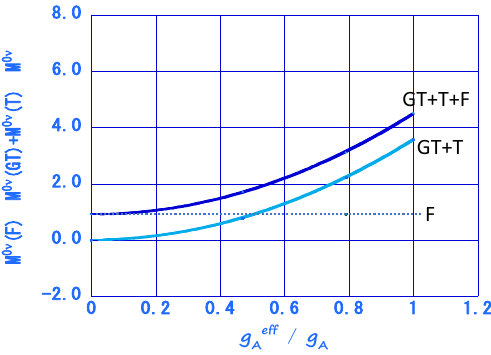
Figure 14. Neutrinoless DBD NMEs as a function of the quenching coefficient g ef f M 0 ν : GT + T + F. M 0 ν (GT) + M 0 ν (T): GT + T. M 0 ν (F):